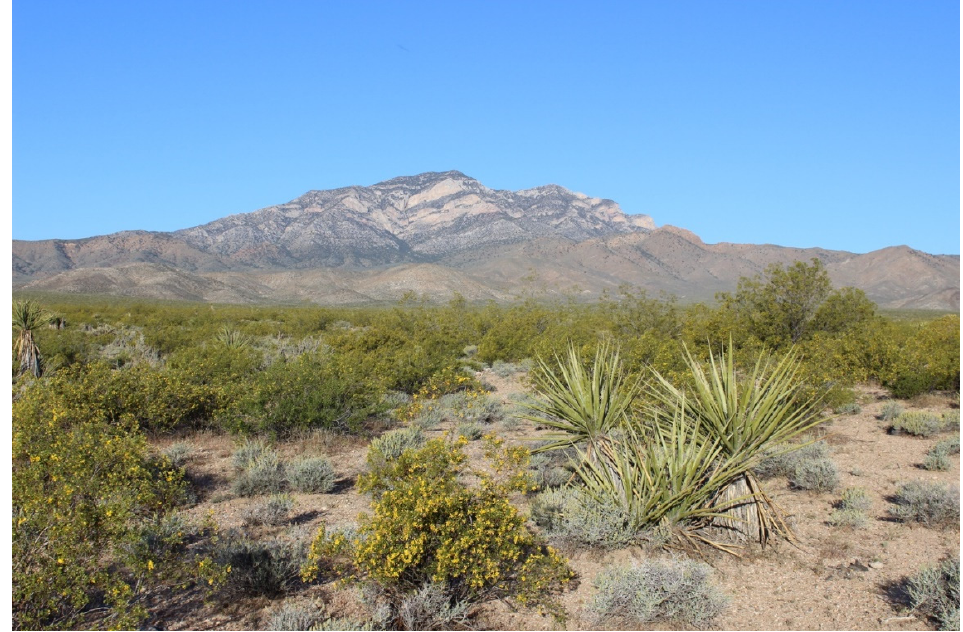
Figure 2. Creosote desert scrub vegetation community during spring in the Ivanpah Valley, Mojave Desert, California, USA. Photograph credit: Steve Grodsky.